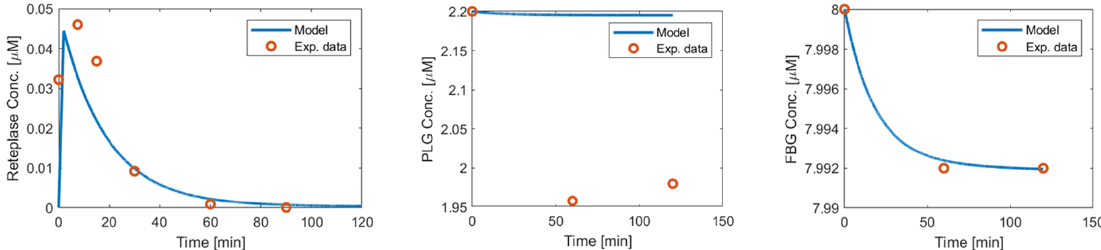
Figure A2. Comparison between simulation results and clinical results from Ulrich et al. [37].